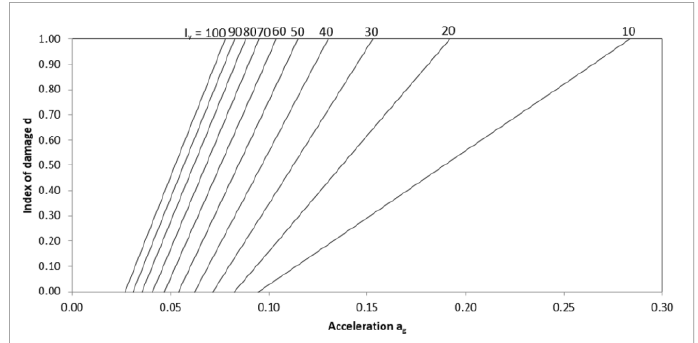
Figure 16. Vulnerability curves for the test site.